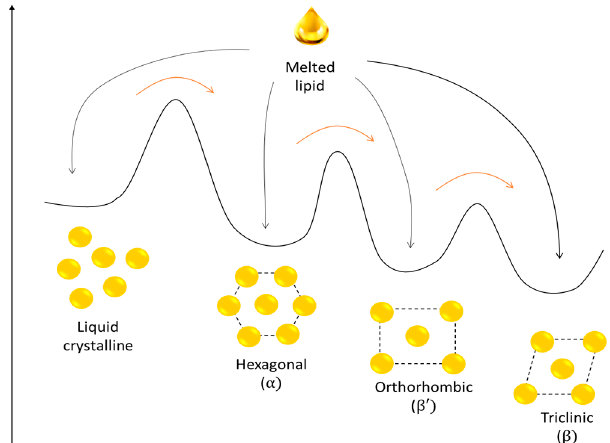
Figure 2. Schematic representation of the energy landscape of different lipid structures and possible polymorphic transformations. Black arrows represent crystallization process after nanoparticle formation; different structures can be formed in the same process. Red arrows represent spontaneous crystal structure transformation during nanoparticle storage.